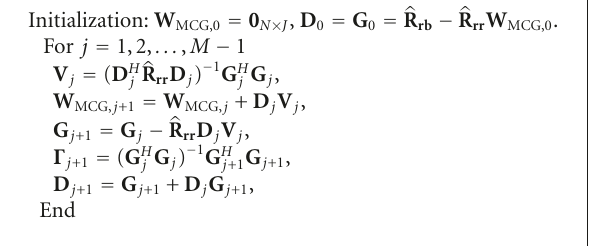
Algorithm 2: Recursion equations for the MCG